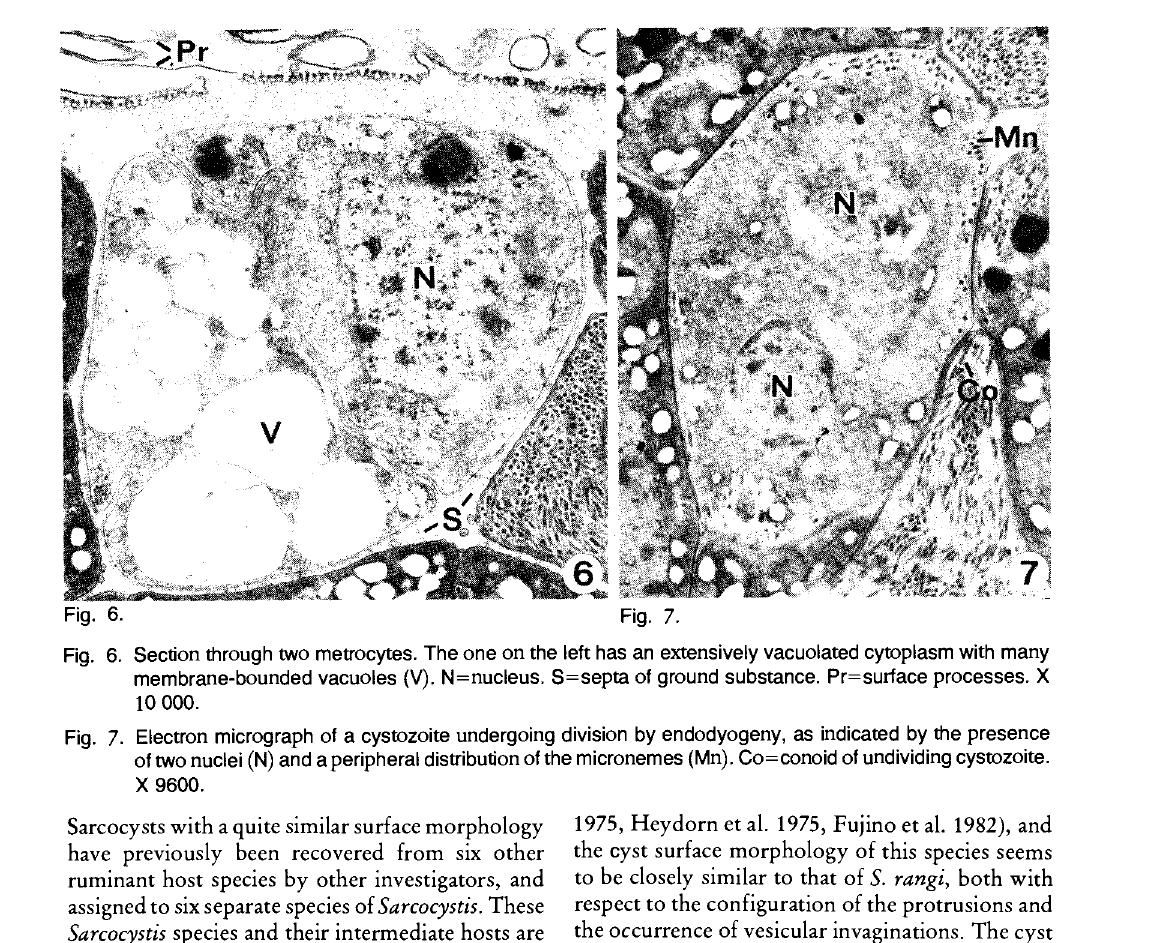
Fig. 6. Section through two metrocytes. The one on the left has an extensively vacuolated cytoplasm with many membrane-bounded vacuoles (V). N=nucleus. S=septa of ground substance. Pr=surface processes. X 10 000. Fig. 7. Electron micrograph of a cystozoite undergoing division by endodyogeny, as indicated by the presence of two nuclei (N) and a peripheral distribution of the micronemes (Mn). Co=conoid of undividing cystozoite. X